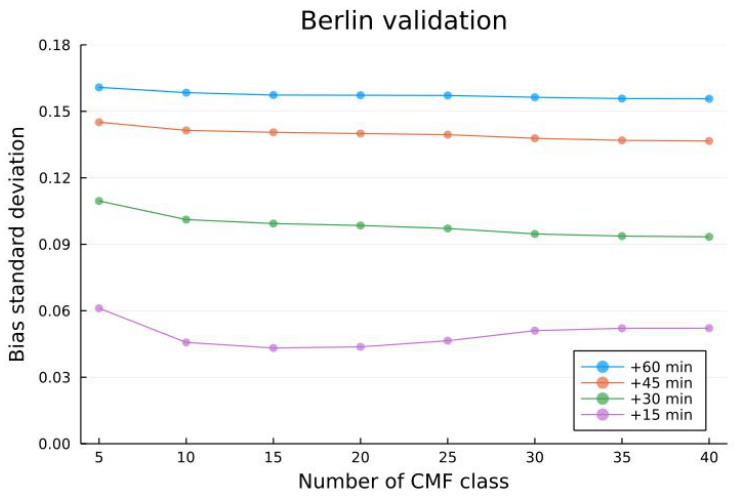
Figure 3. Bias standard deviation of MC-based model with different numbers of classes for the validation set (2019) in Berlin.